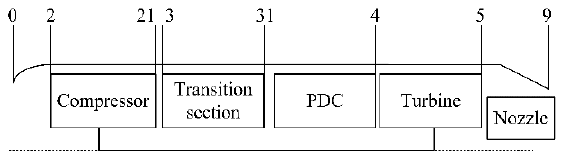
Figure 1. Schematic model of PDTE.